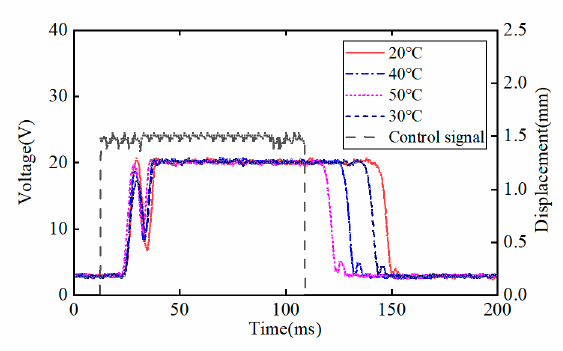
Figure 23. Solenoid valve response curve at di ff erent temperatures.